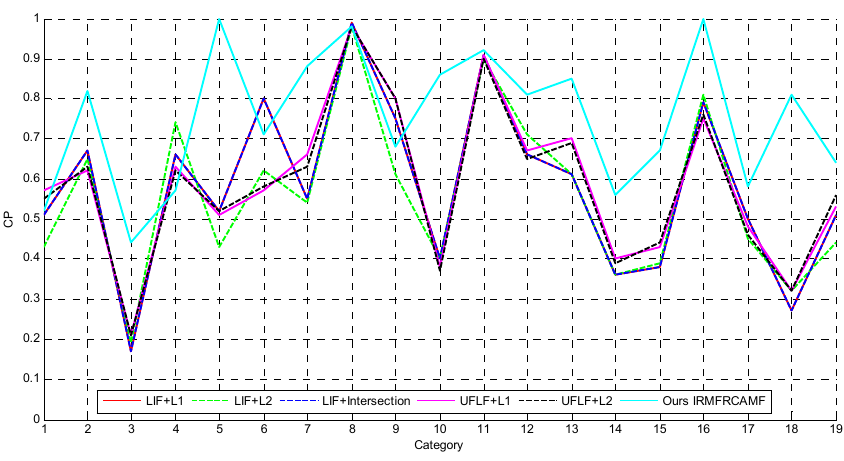
Figure 12. Class-level precision (CP) among different methods. Table 12. Dataset-level precision (DP) under different methods.